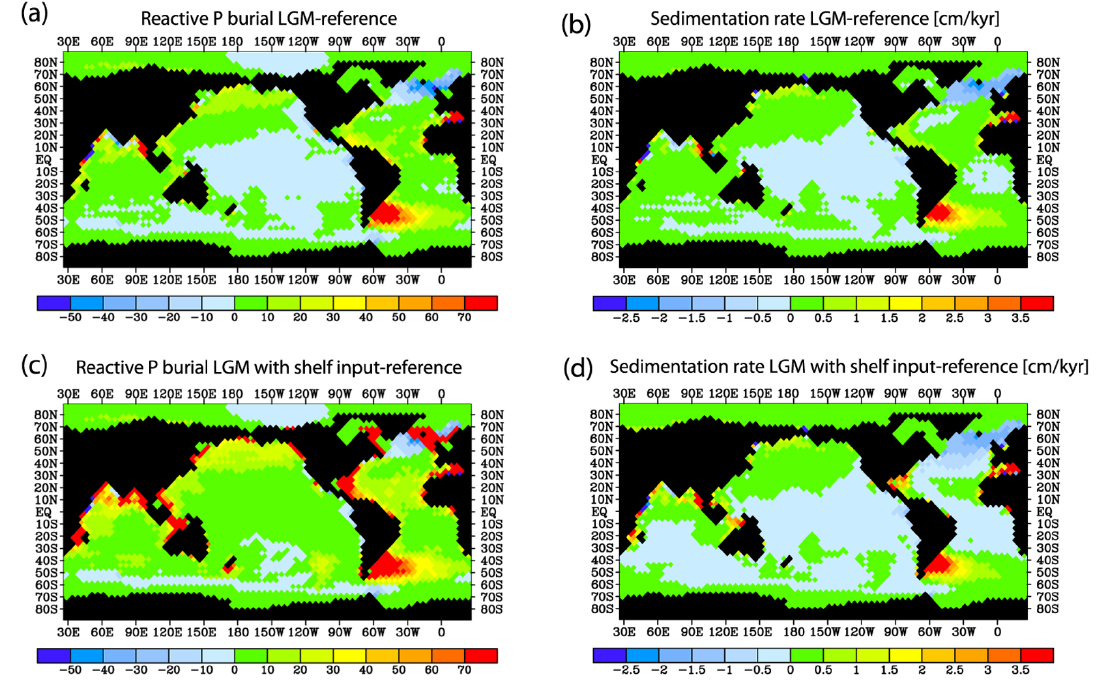
Fig. 8. Anomalies relative to the reference run in reactive P burial (in µmolcm − 2 kyr − 1 ) and total sedimentation rates (in cmkyr − 1 ) in (a, b) the LGM simulation and (c, d) the LGM simulation with shelf